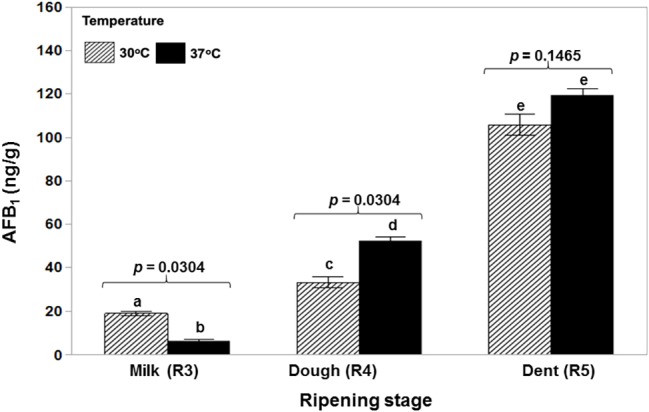
Relative contamination of maize cobs of different ripening ages (R3, R4, R5) with aflatoxin B1 when incubated at the actual water activity levels of the maize kernels at the different growth stages at 30 and 37°C. The toxigenic strain NRRL 3375 was used. The values of p indicate no evidence of difference between temperatures. Ripening stage treatments with the same letters were not significantly different using the Wilcoxon for each pair test (p ≥ 0.05). Overall analyses was done using the Non-Parametric data – Wilcoxon Test. Ripening stages: R3 × R4 × R5, p = 0.0009; Temperatures: 30 × 37°C, p = 0.7728.